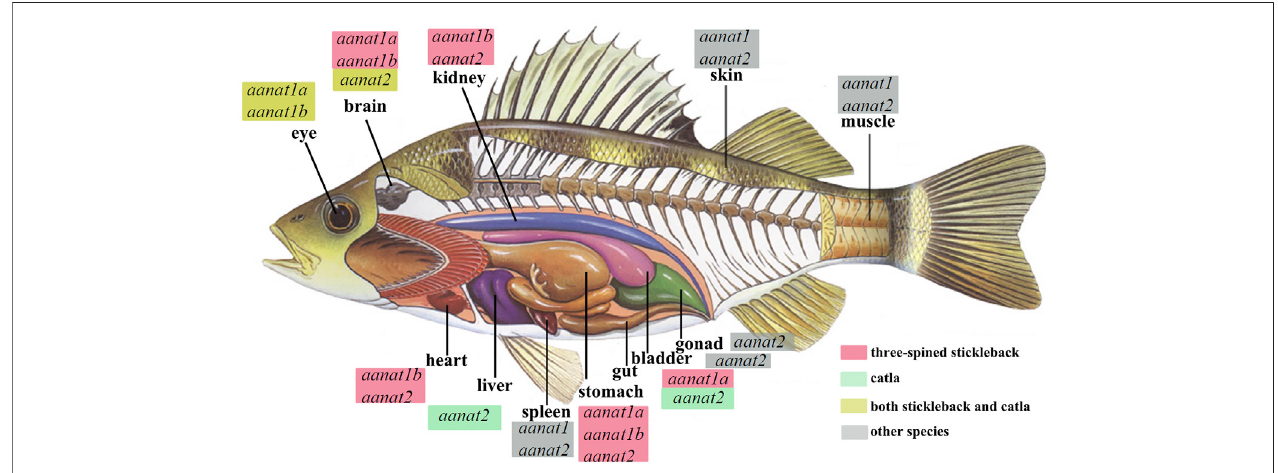
FIGURE 5 | Endogenous sources of melatonin and aanat expression in various fi shes, including carp ( Catla ; Maitra and Pal, 2017) and three-spined stickleback ( Gasterosteusaculeatus ;Kulczykowskaetal.,2017).Detectionof aanat mRNAindifferenttissuesisaccordingtothereferences. aanat witharedboxmarksitsexistence inthecorrespondingtissueofthestickleback, aanat withagreenboxreferstoitsexistenceinthecatlacarp,whilethosewithayellowboxmeans aanat (s)expressedboth insticklebackandcatla. “ Otherspecies ” arethegoldlinedspinefoot( Siganusguttatus ),rainbowtrout( Oncorhynchusmykiss ),gold fi sh( Carassiusauratus ),andsea bass ( Dicentrarchus labrax ) (Kulczykowska et al.,